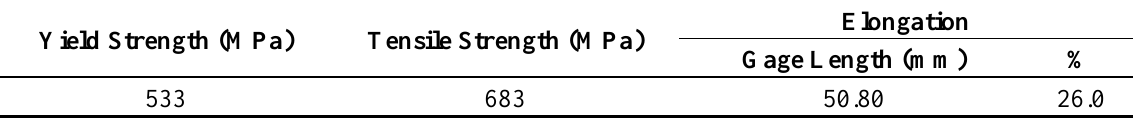
Table 2. Mechanical properties of modified 9Cr-1Mo